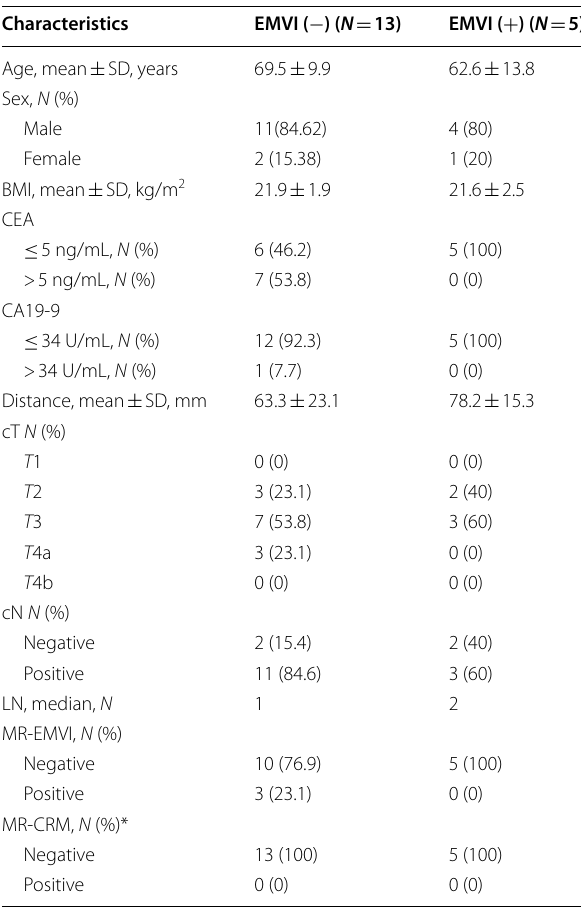
Table 3 Associations between EMVI and clinical risk predictors in test